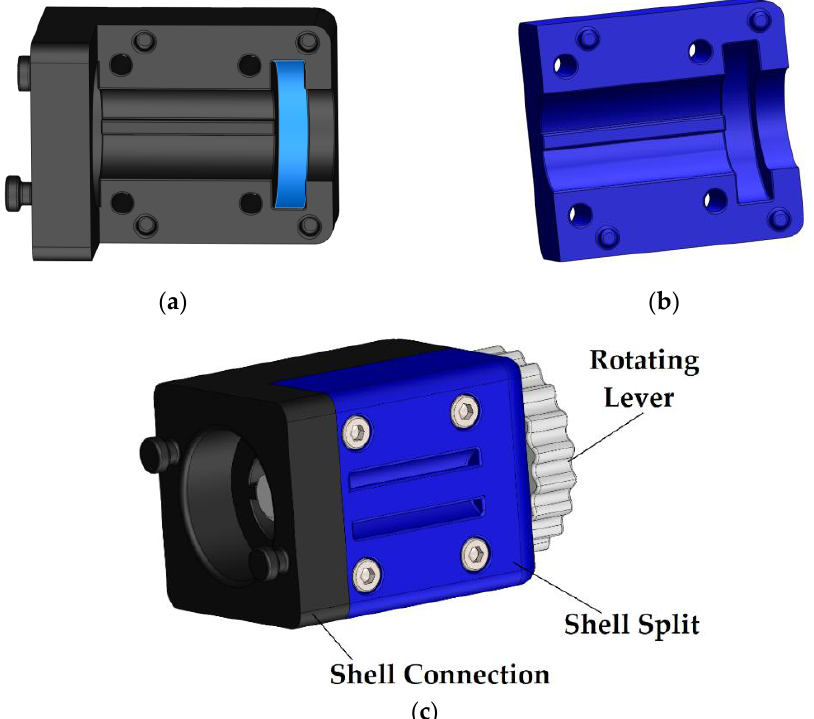
Figure 3. ( a ) General view of “Shell Connection” with marked surfaces for mounting cylinder; ( b ) general view of “Shell Split”; ( c ) view of “Shell Connection”, “Shell Split”, and “Rotating Lever”.